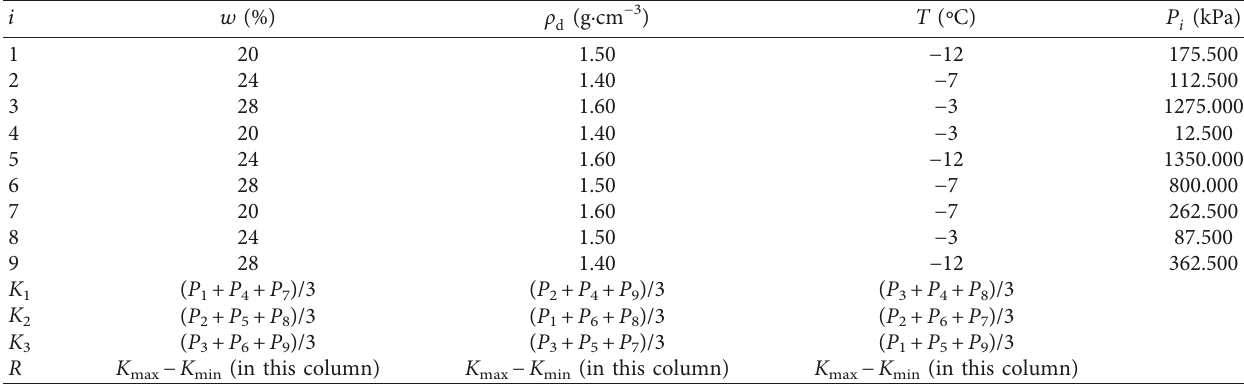
Table 3: Significance analysis.